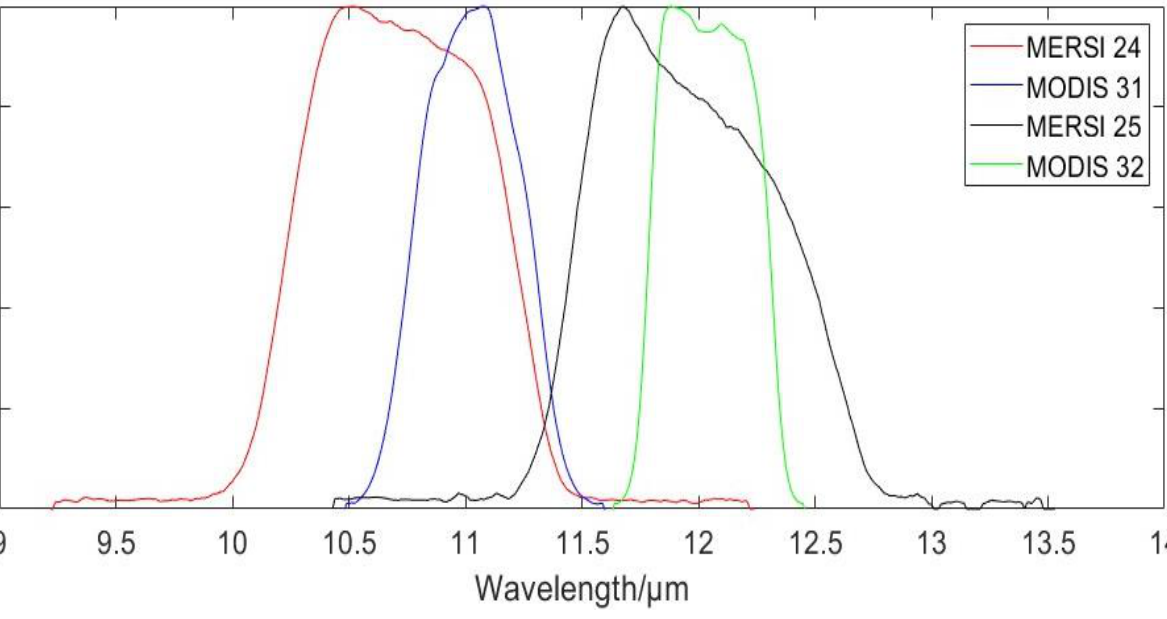
Figure 1. MERSI (channels 24 and 25) and MODIS (channels 31 and 32) central wavelengths at 11 μm and 12 μm spectral response function.